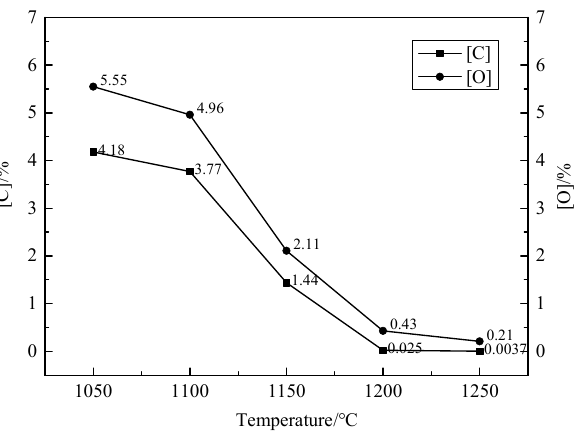
Figure 13. Carbon and oxygen content in samples at 10 −4 atm and different temperatures.